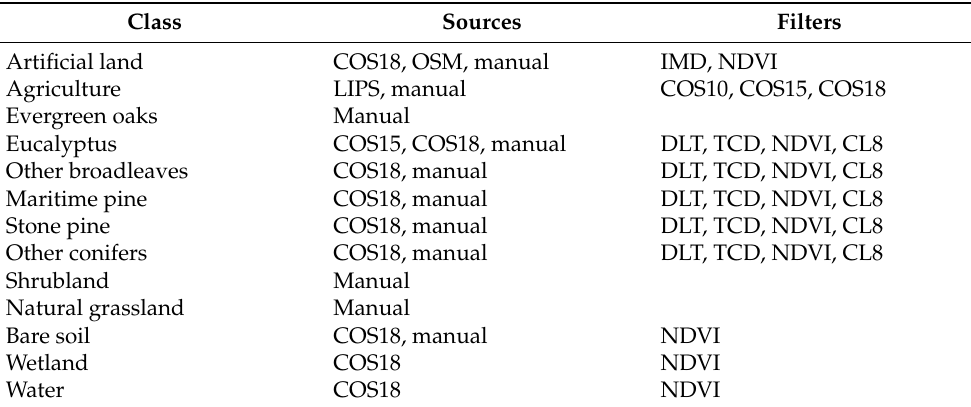
Table 2. Summary of the data sources and filtering criteria applied to delimit polygons to select training samples. Acronyms as defined in Section